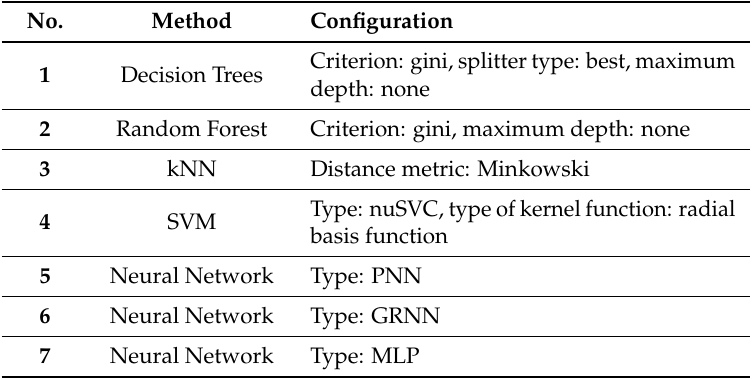
Table 3. Computational intelligence methods and their basic parameters used for LIBS spectra